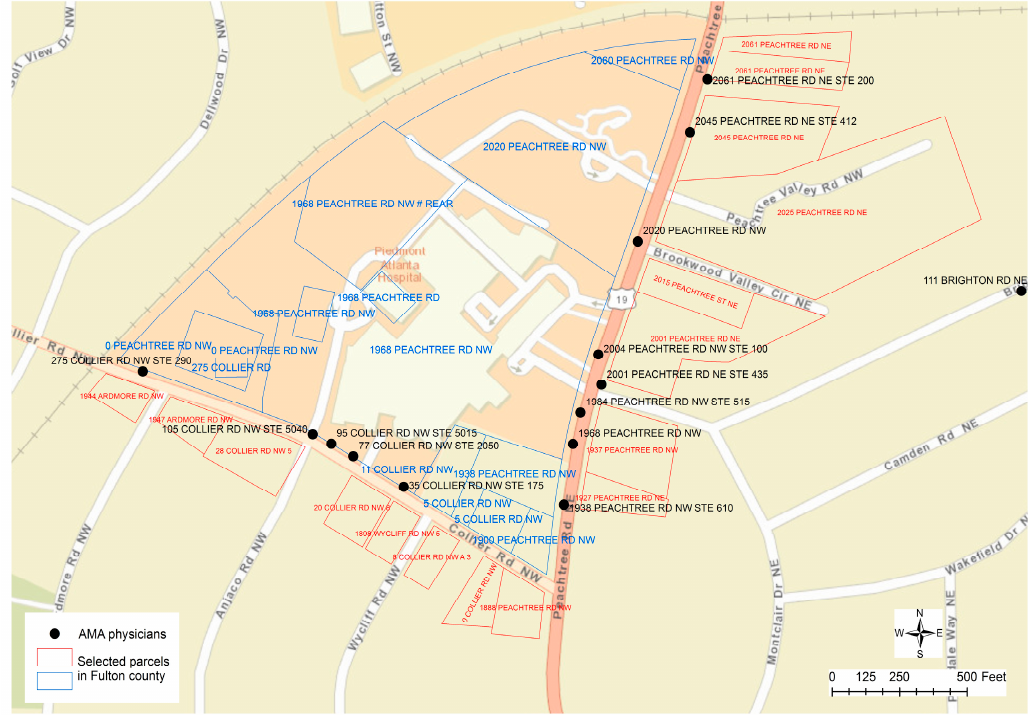
Figure 2. Discrete and inconsistent address assignment and distribution in a parcel dataset.